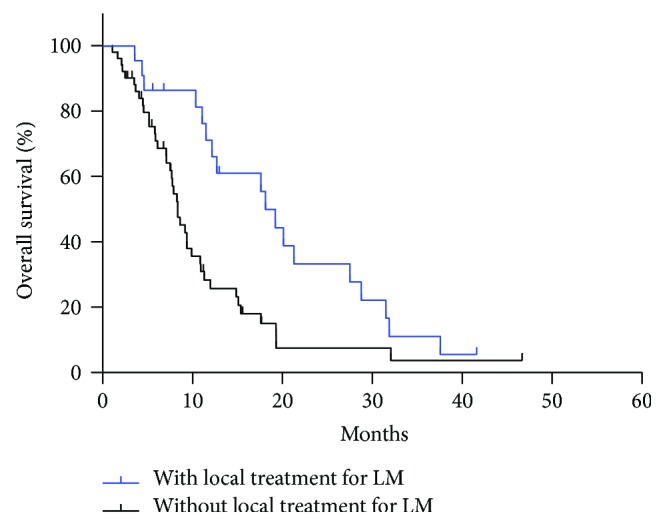
In serum AFP ≥ 20 ng/ml GCLM, the median OS of group 1 (with local treatment for LM) and group 2 (without local treatment for LM) was 19.2 m and 18.3 m, respectively (P = 0.003).